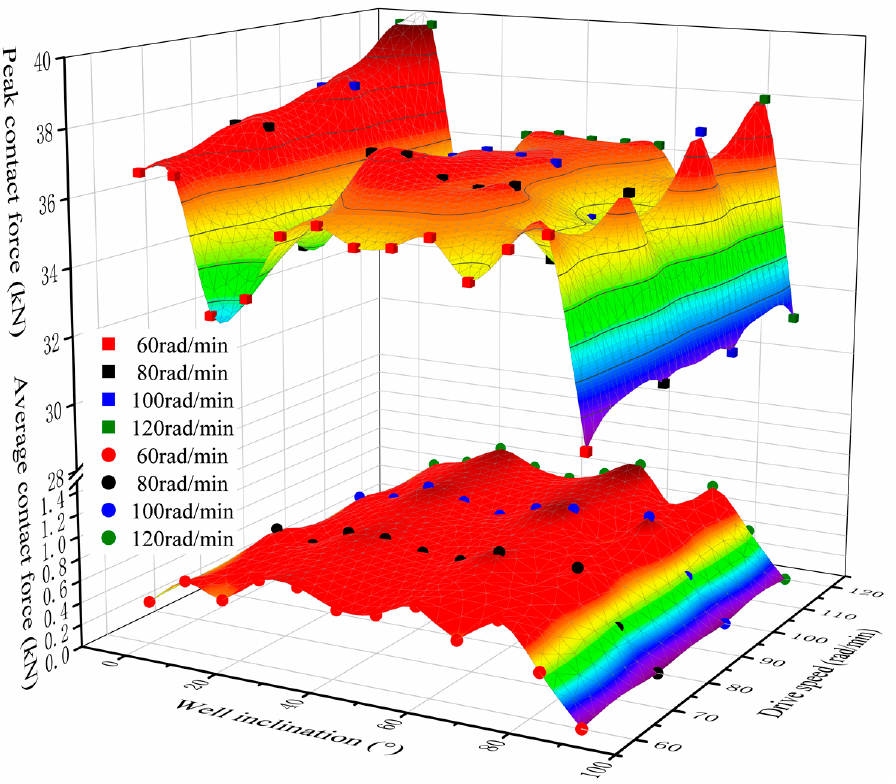
Figure 17. Contact force change curve of flexible drill pipe at different driving